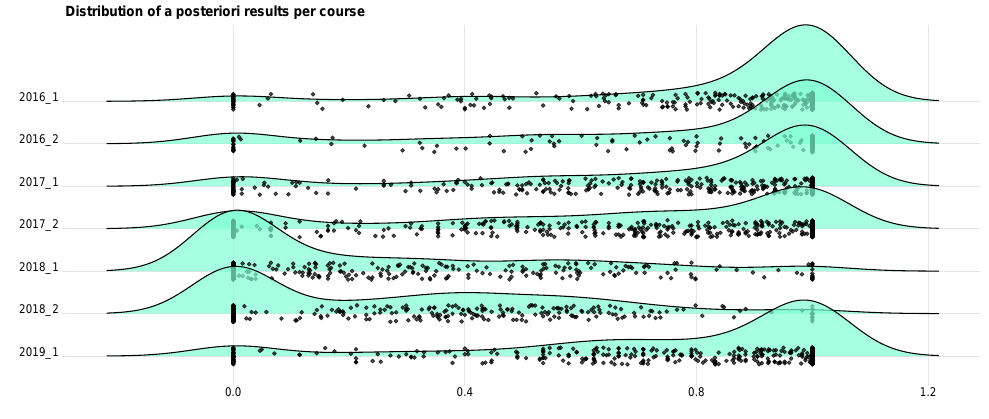
Figure 3. Distribution of students by academic semester.